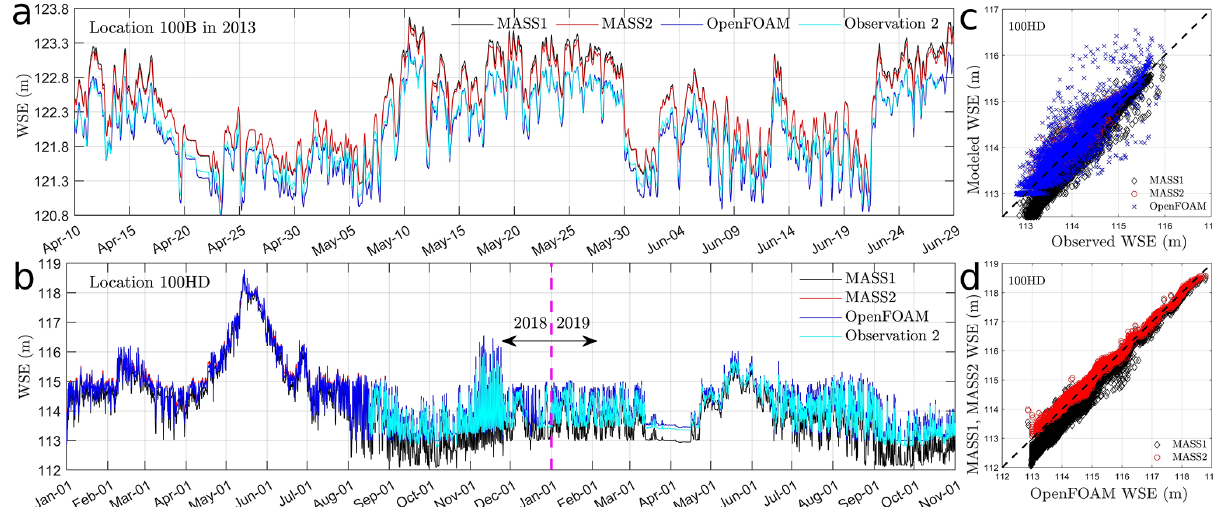
Figure 13. A comparison of water surface elevation (WSE) from MASS1, MASS2, OpenFOAM, and observations at 100B during 2013 (a) and at 100HD during 2018–2019 (b) . Panel (c) denotes the 1 : 1 plot of WSE between models and observation for 100HD, and (d) denotes that between OpenFOAM and MASS1/2. Details of the WSE from MASS1 and MASS2 can be found in Niehus et al.